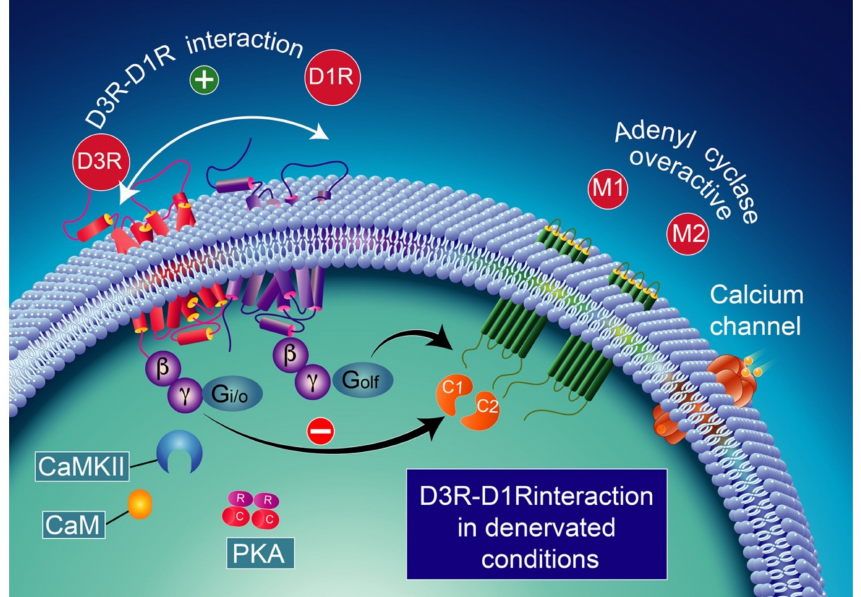
Figure 6. D1R and D3R interaction in denervated conditions. D3R activation switches to inhibitory action upon D1R stimulation. CaMKII activation is no longer expected to occur [246] probably due to the low expression of calmodulin. The D3R activation in denervated dyskinesia rats prevents D1R-induced GABA release at striatonigral terminals. This effect appears to be mediated by an antagonist interaction between the two receptors. CaMKII-calcium/calmodulin-dependent protein kinase II;